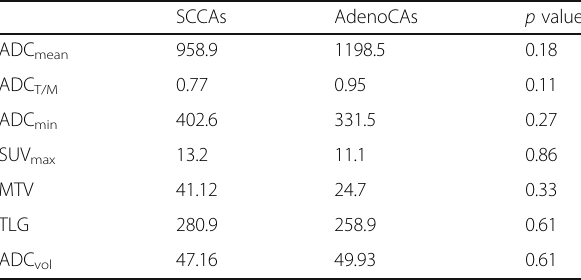
Table 2 Comparison of global tumor imaging metrics between SCCAs and